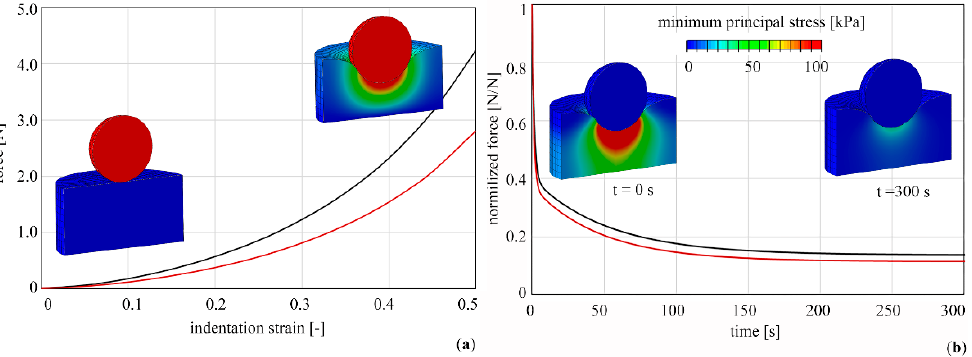
Figure 6. Computational analysis of indentation tests for VAT (red lines) and SAT (black lines). ( a ) Equilibrium stress-indentation strain with contours of displacement magnitude in unstrained and strained configurations. ( b ) Normalized stress-time responses of indentation tests with contours of minimum principal stress at time t = 0 s and t = 300 s.